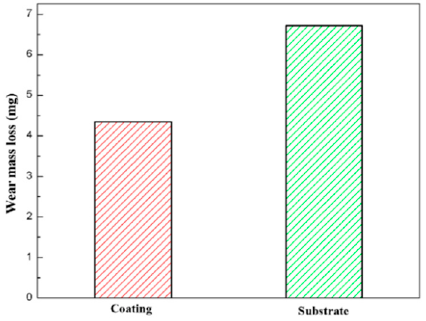
Figure 15. The wear mass loss of the composite coating and substrate.